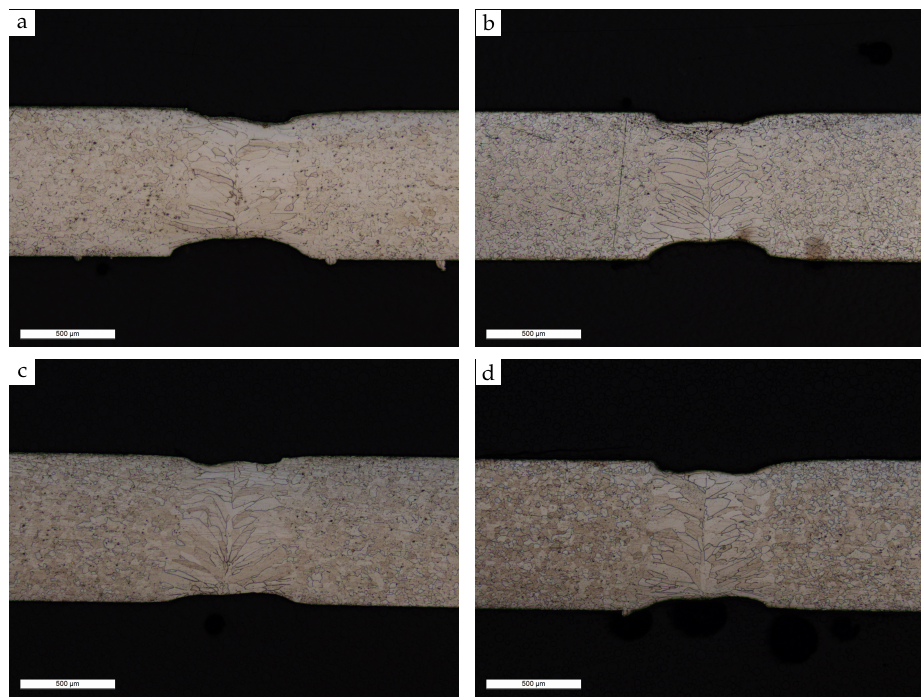
Figure 7. Etched macrographs of AISI430Ti weld seams obtained at energy inputs of ( a ) 18 J · mm − 1 , ( b ) 20 J · mm − 1 , ( c ) 22 J · mm − 1 and ( d ) 24 J · mm − 1